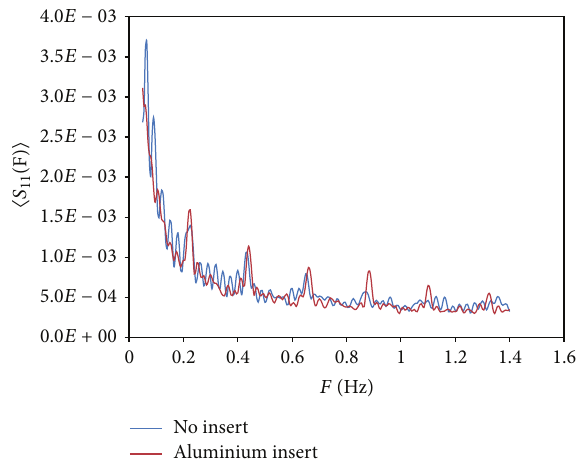
Figure 9: Breathing frequency detection at position B without (blue line) and with (red line) the insertion of an aluminum sheet in the high visibility